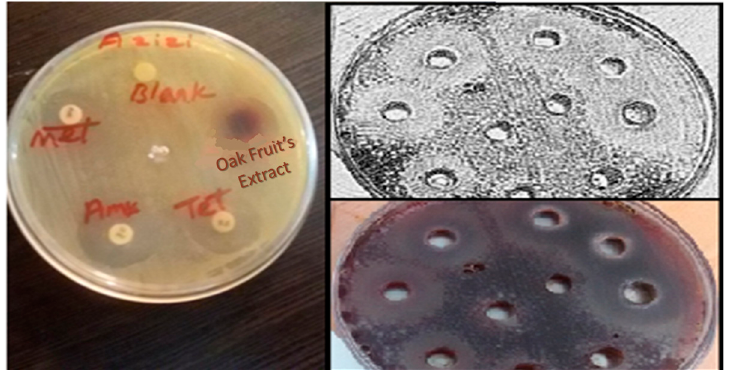
Figure 6. The inhibition zone of extract of Oak fruit for antibacterial activity using disc diffusion method and Agar well diffusion method.